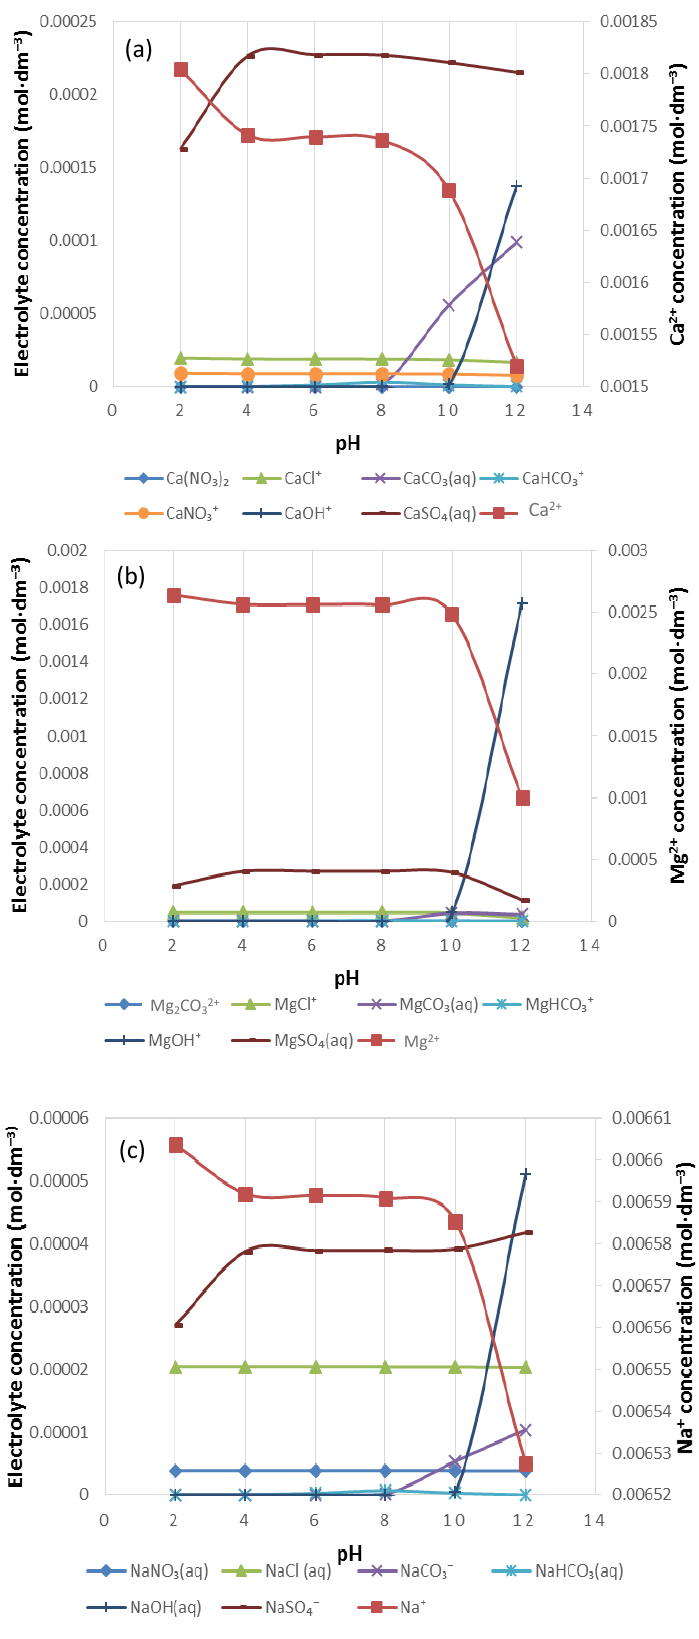
2 + , ( b ) Mg 2 + and ( c ) Na + in Figure 8. The speciation of ( a ) Ca 2+ , ( b ) Mg 2+ and ( c ) Na + in 1SPW. Figure 8. The speciation of ( a ) Ca